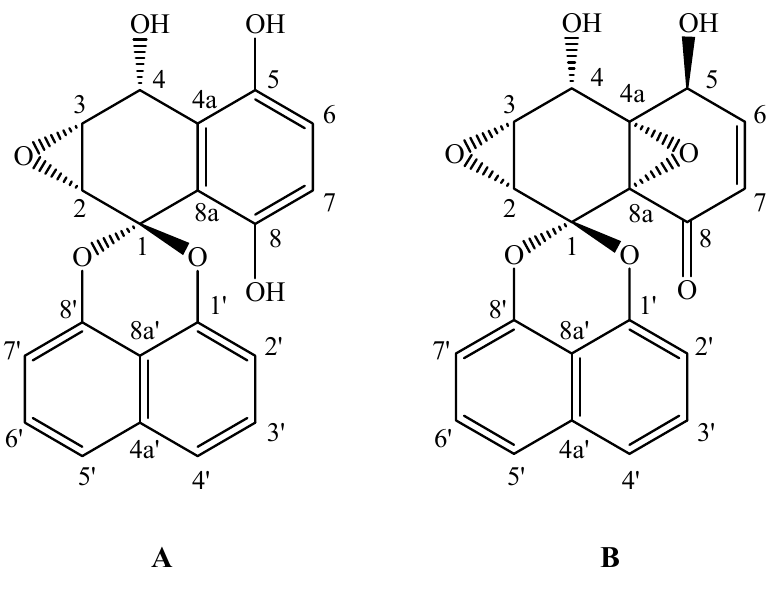
( A ) and C ( B 12 13